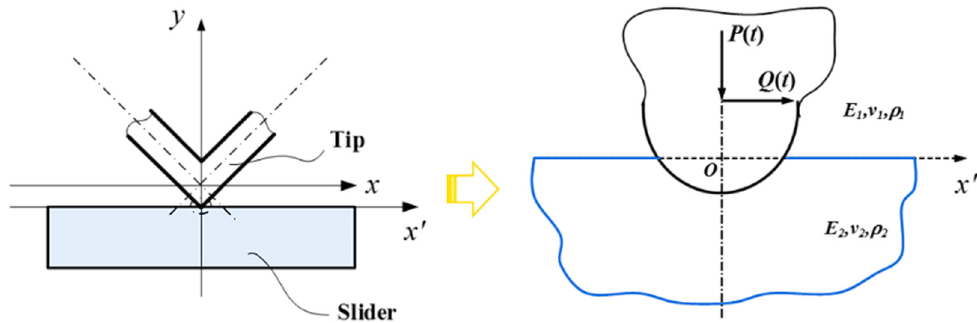
Figure 8. Hertzian contact model of the driving tip of a V-shaped vibrator with a cylindrical configuration and metal slider.